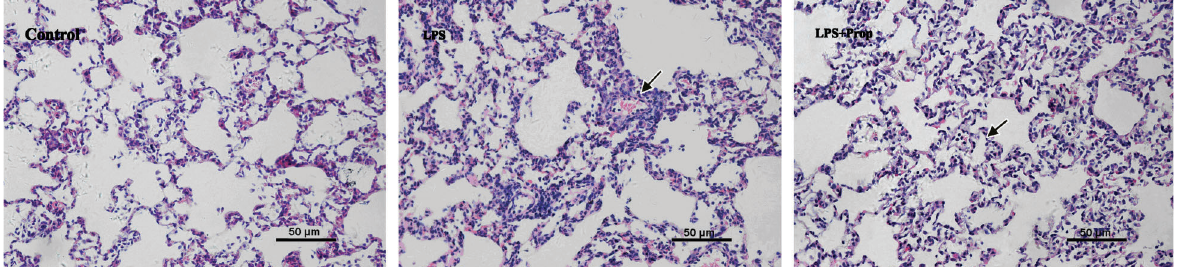
Figure 1. Histological findings for control (left), LPS (middle), and LPS + Prop (right) groups (H&E stain). Significant alveolar edema, hemorrhage, wall thickening, hyperinflation, and infiltration of inflammatory cells in alveolar spaces can be seen in the LPS group (arrow). These changes were less prominent in the rats that received LPS + Prop (arrow). LPS = lipopolysaccharide; Prop = propofol. Magnification bar = 50 m m.